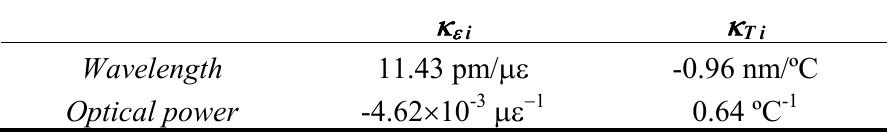
Table 5. Strain and temperature coefficients for the concatenated